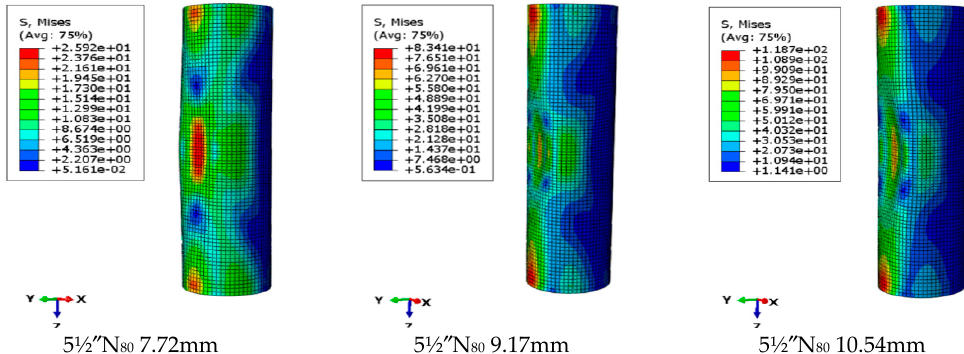
Figure 11. Finite element deformation simulation of different casing wall thicknesses.